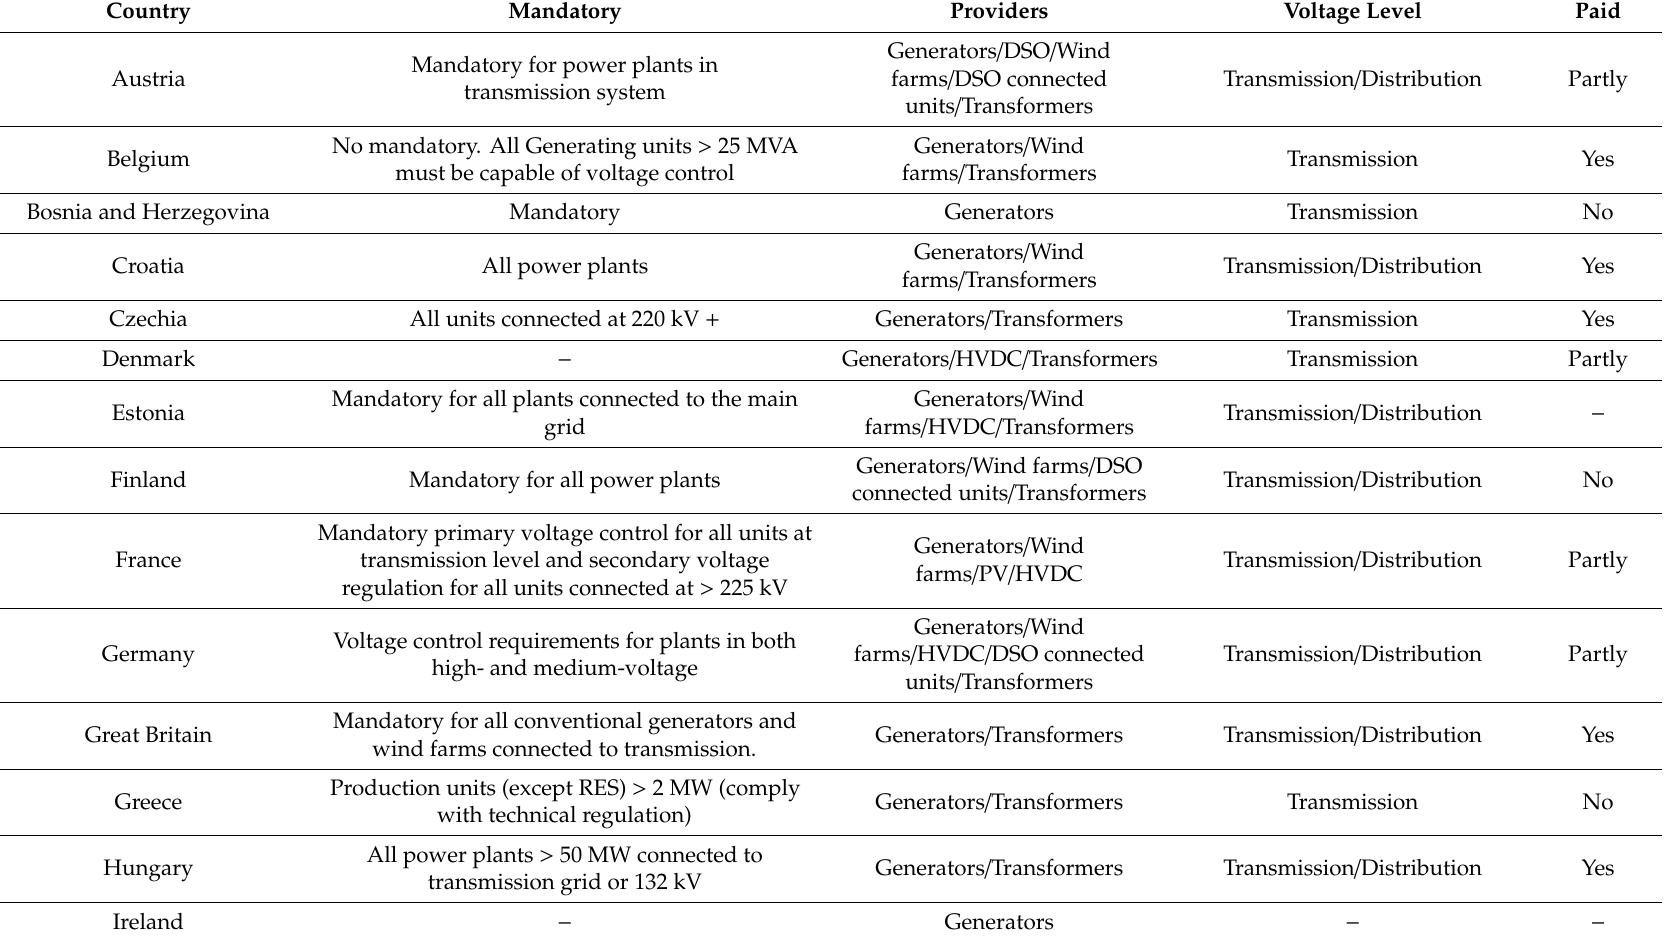
Table A2. Voltage control in various EU